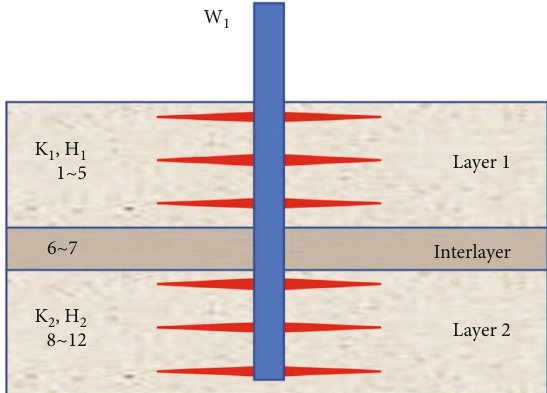
Figure 4: Gas-water relative permeability curve.